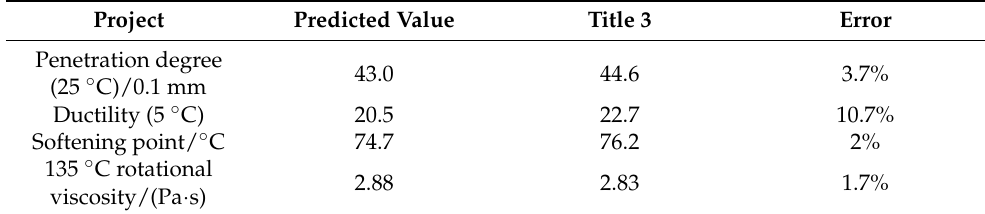
Table 10. Optimal dosage-asphalt performance test results.